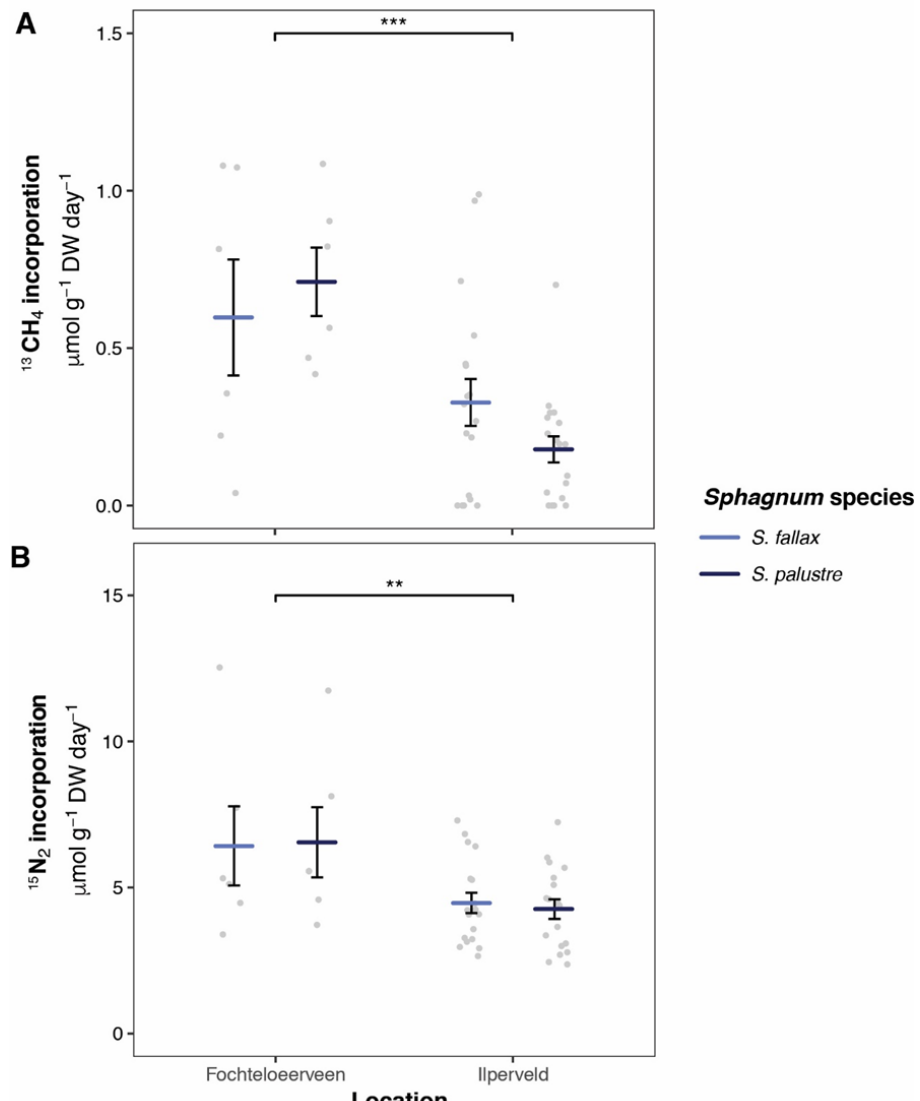
Figure 2. A: Methane oxidation activity ( 13 C-CH 4 incorporation rate); and B: Nitrogen fixation ( 15 N-N 2 incorporation rate) for Sphagnum fallax (light blue) and S. palustre (dark blue) indicated per site (FV and IV). Significant differences are indicated as follows *** p<0.001; ** p<0.01; * P<0.05; ns = not